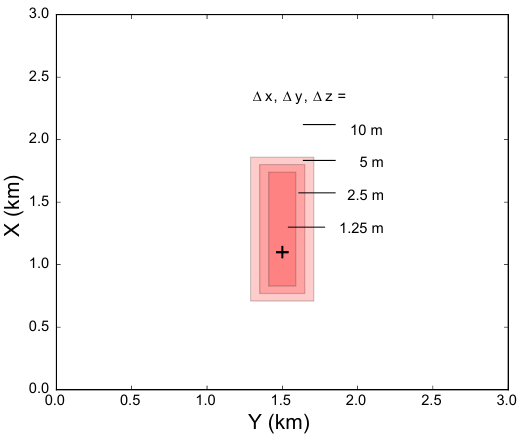
Figure 2. Schematic of the SOWFA mesh, with model resolutions labeled at their respective locations in the domain. Turbine location is denoted by the plus